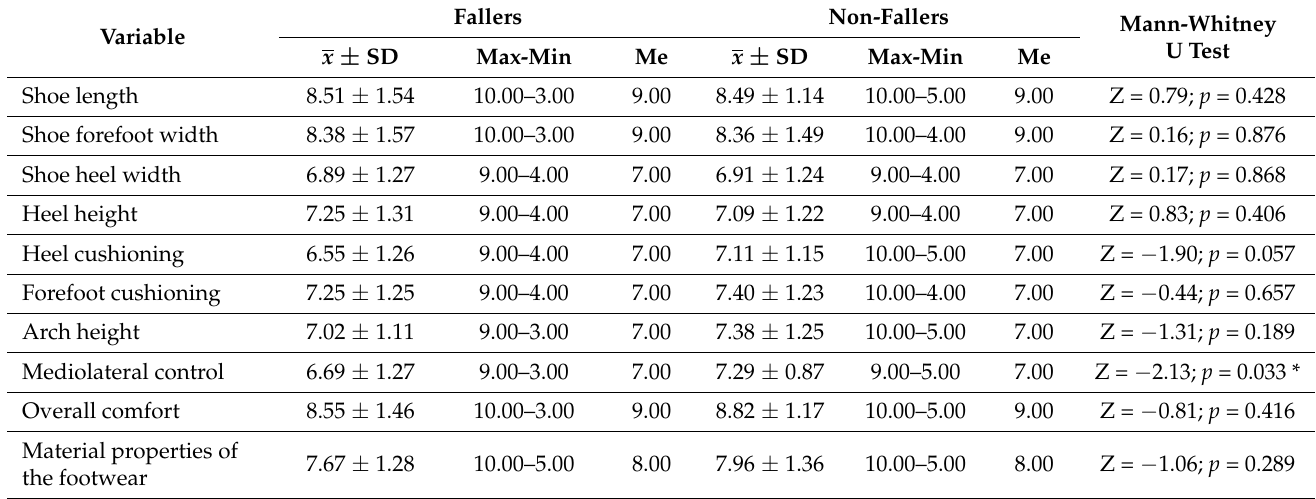
Table 4. Subjective assessment of the comfort of the footwear in people who have and have not suffered a fall within the last year.